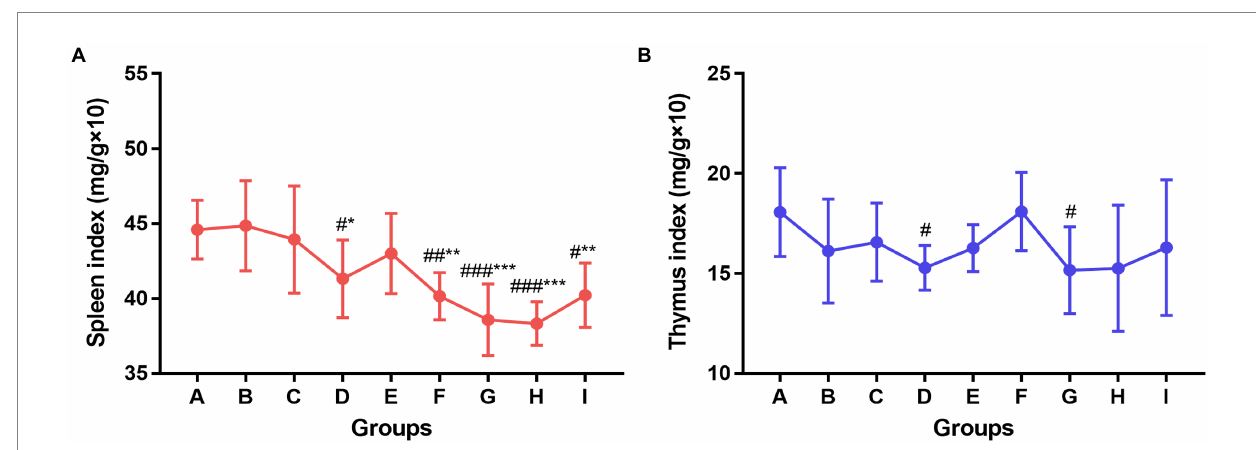
FIGURE 4 Changes of spleen index (A) and thymus index (B) among groups. Significant differences were observed between the PBS group and the vaccination groups ( # p < 0.05, ## p < 0.01, ### p < 0.001), and between the influenza vaccination alone group and the other vaccination groups (* p < 0.05, ** p < 0.01, *** p <